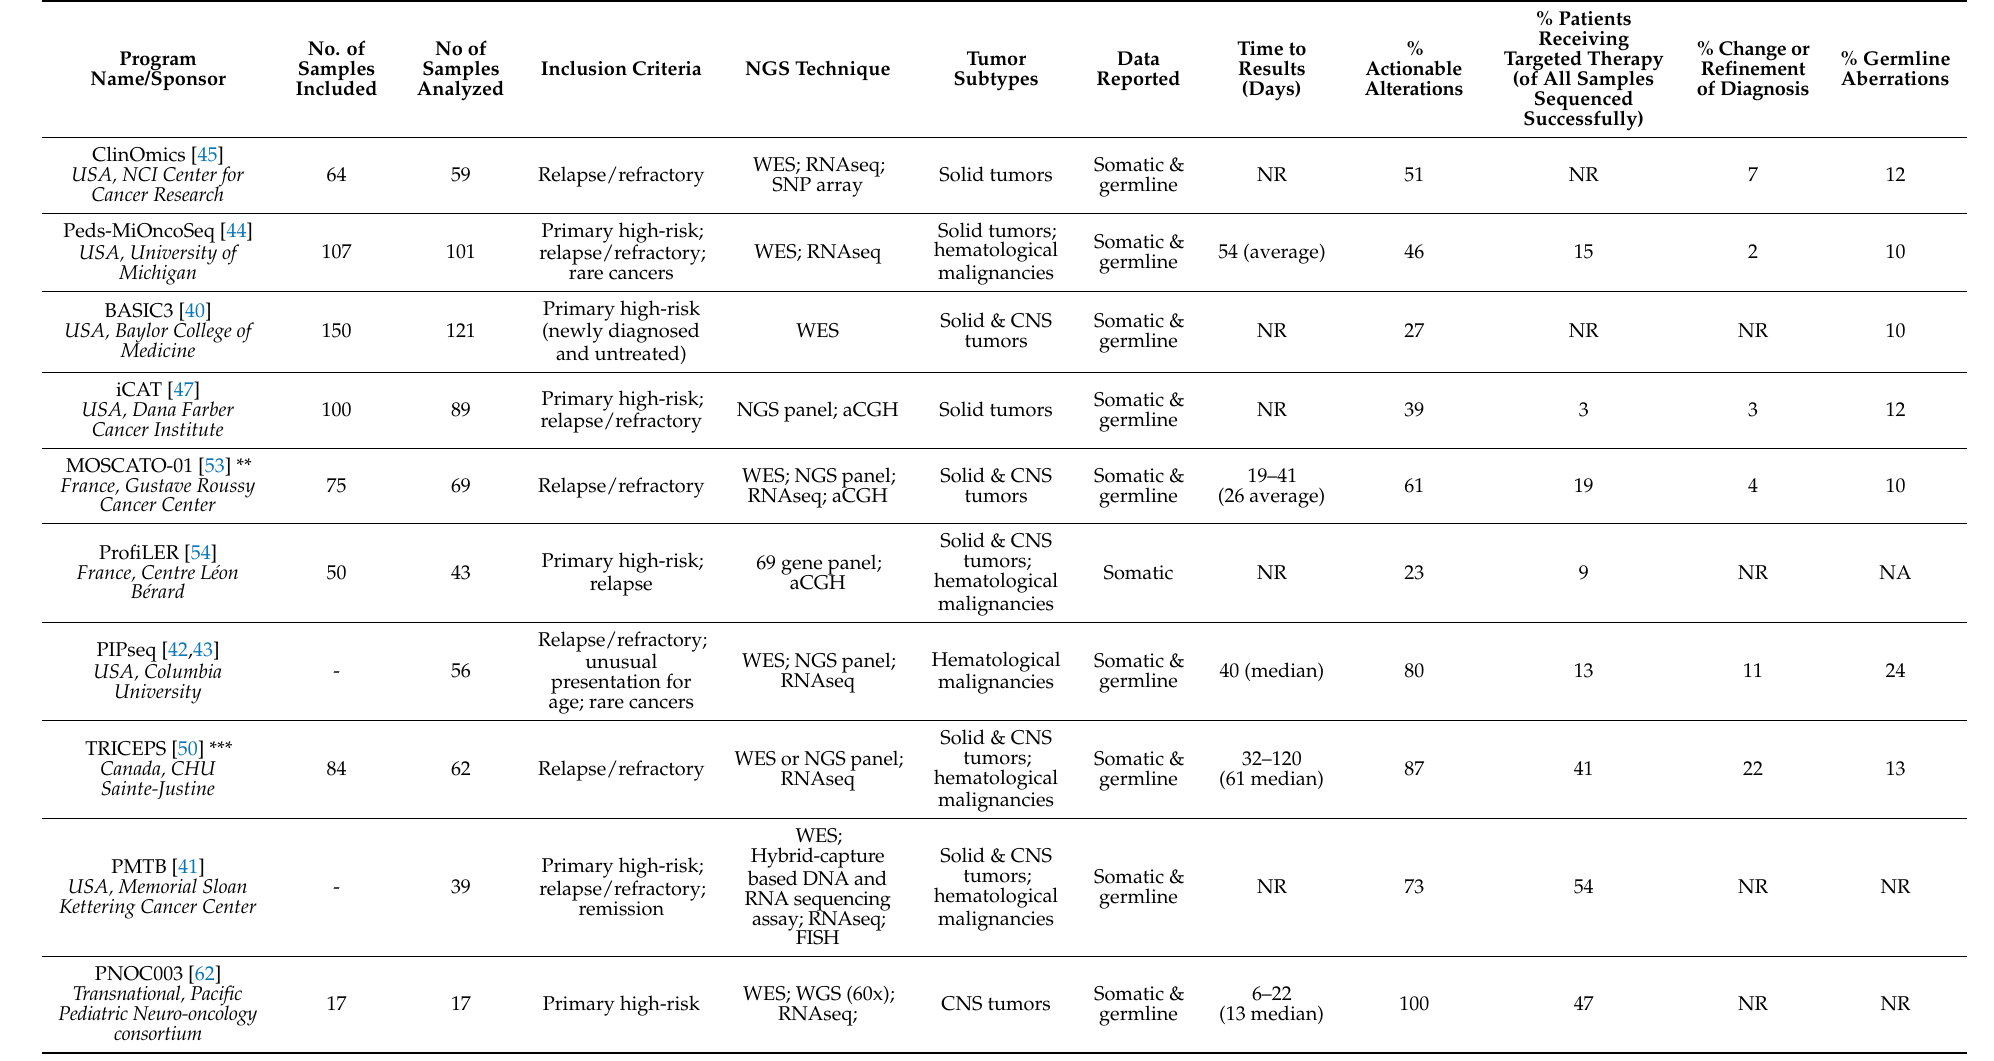
Table 1. Characteristics and results of published pediatric precision medicine